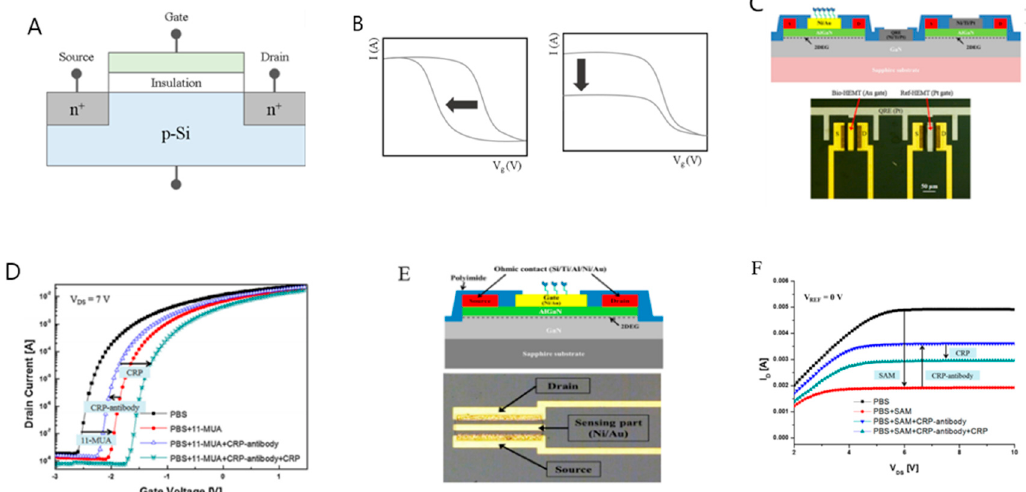
Figure 1. ( A ) Field-effect transistor (FET) structure. ( B ) Example of detection using change in threshold voltage at drain and current change at drain. ( C ) FET-based sensor system composed of heterogeneous AlGaN/GaN layers. ( D ) The state of the gate viewed through the change in the threshold voltage at the drain. ( E ) Another FET-based sensor system composed of heterogeneous AlGaN/GaN layers. ( F ) Gate state observed through current change in drain (Reproduced with permission from [37,38], published by Elsevier 2016, the figure follows the term of use under a Creative Commons Attributions License).